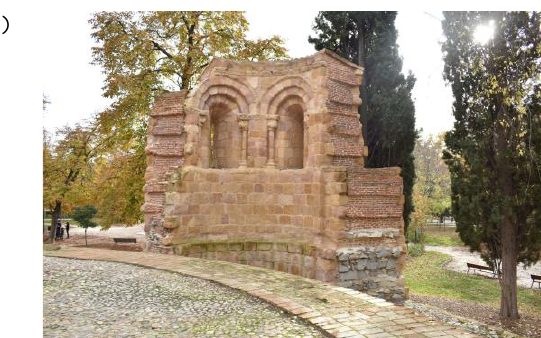
Figure 4. The unique remains of the ruins established in Madrid: a) front façade and; b) apse.